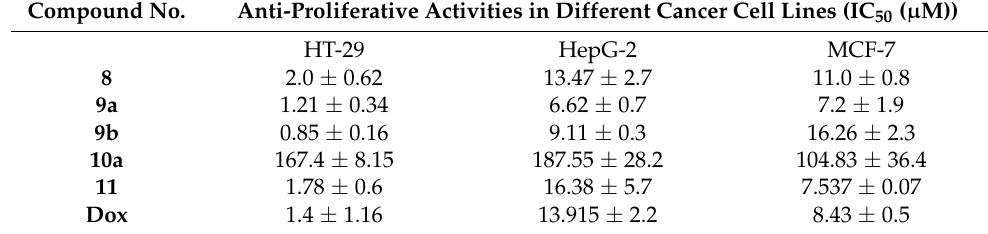
Table 1. Results of anti-proliferative activities of the tested compounds on three cancer cell lines (IC 50 ( µ